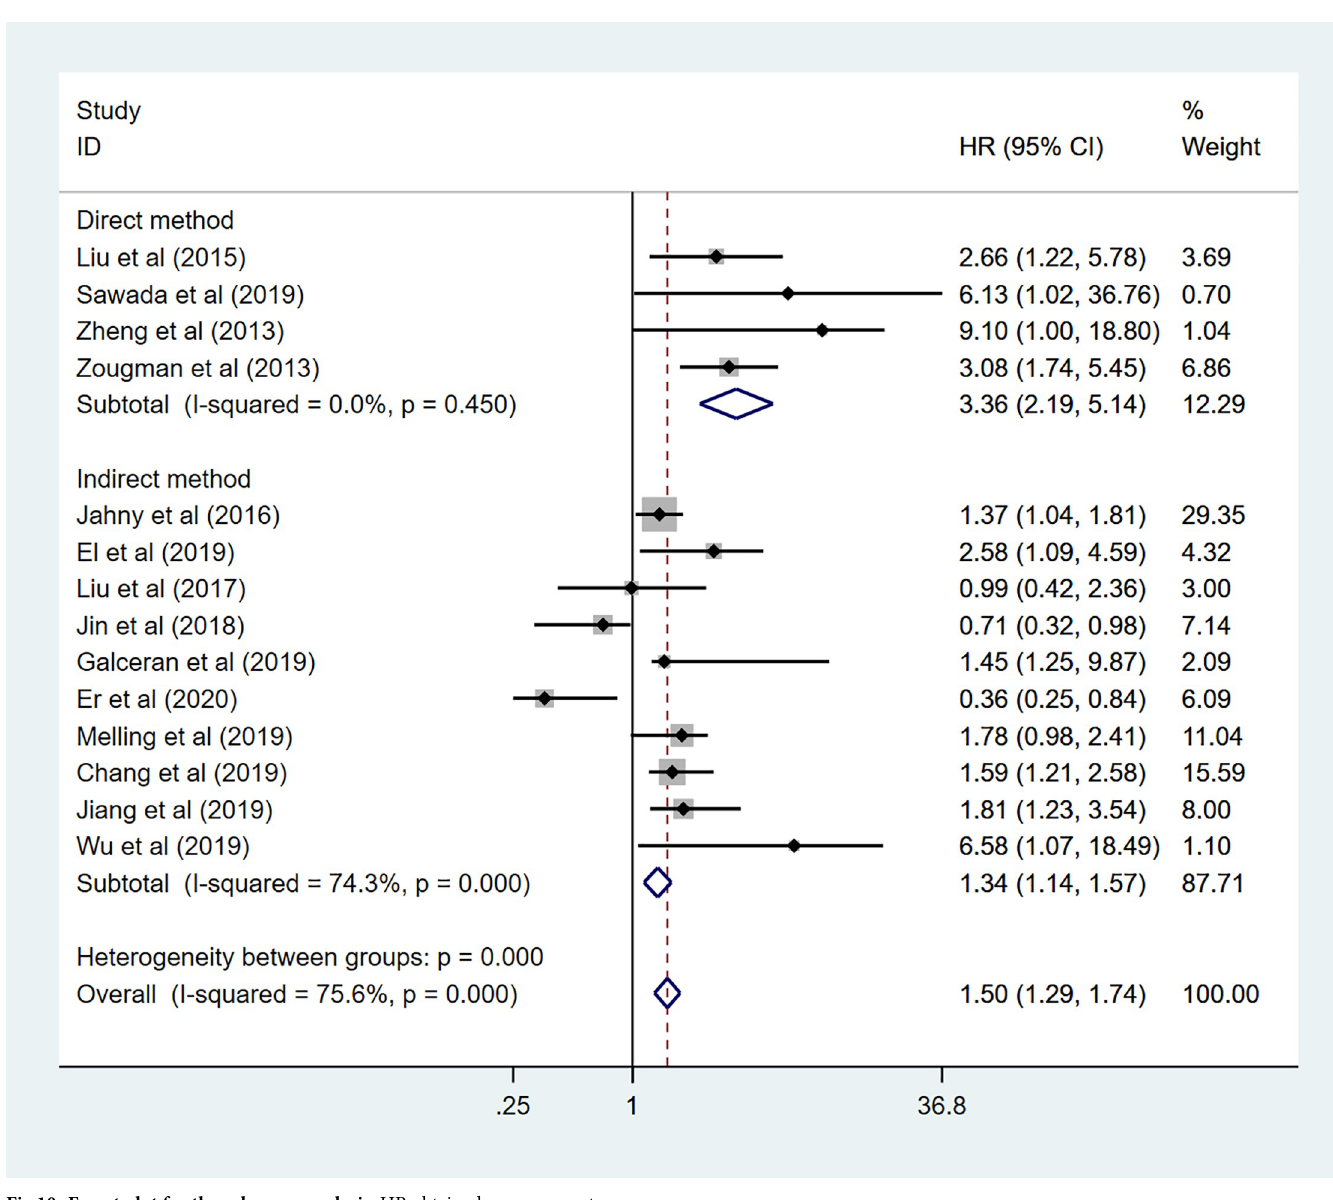
Fig 10. Forest plot for the subgroup analysis. HR obtained